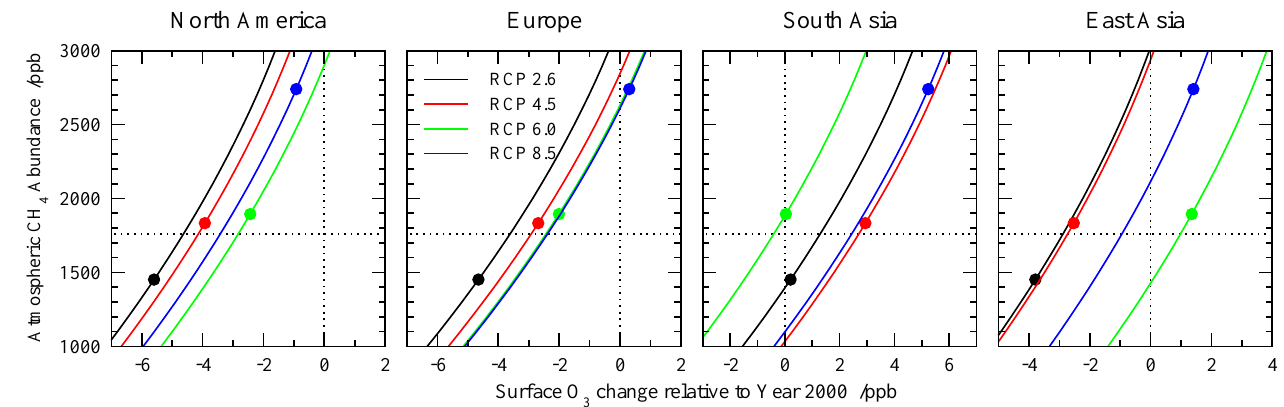
Fig. 11. Sensitivity of regional surface O 3 in 2050 to the atmospheric CH 4 abundance under each of the RCP scenarios. Circles mark the ensemble mean surface O 3 response under each scenario, and curves show how this would change under different levels of CH 4 . Dashed lines mark CH 4 and surface O 3 for year 2000.